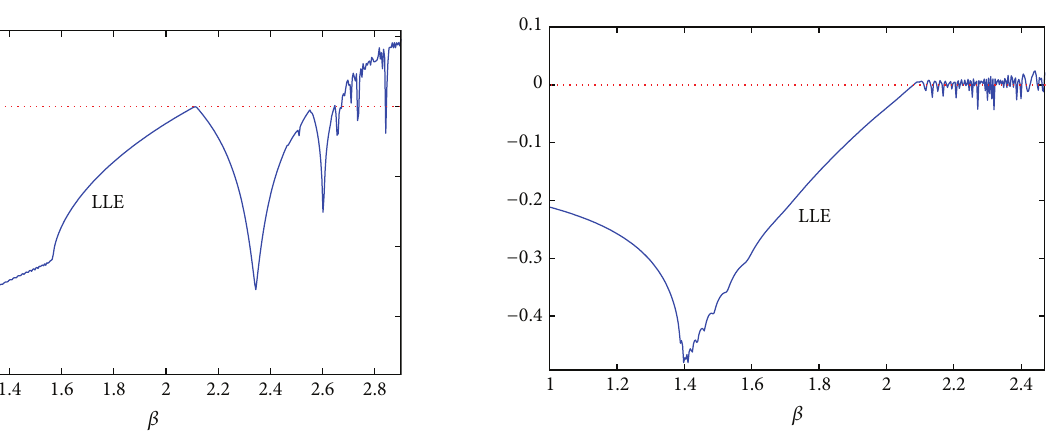
Figure 4: The largest Lyapunov exponent of system (10) for 𝛼 = 1.5 and 𝛽 varying from 1.0 to 2.9 .